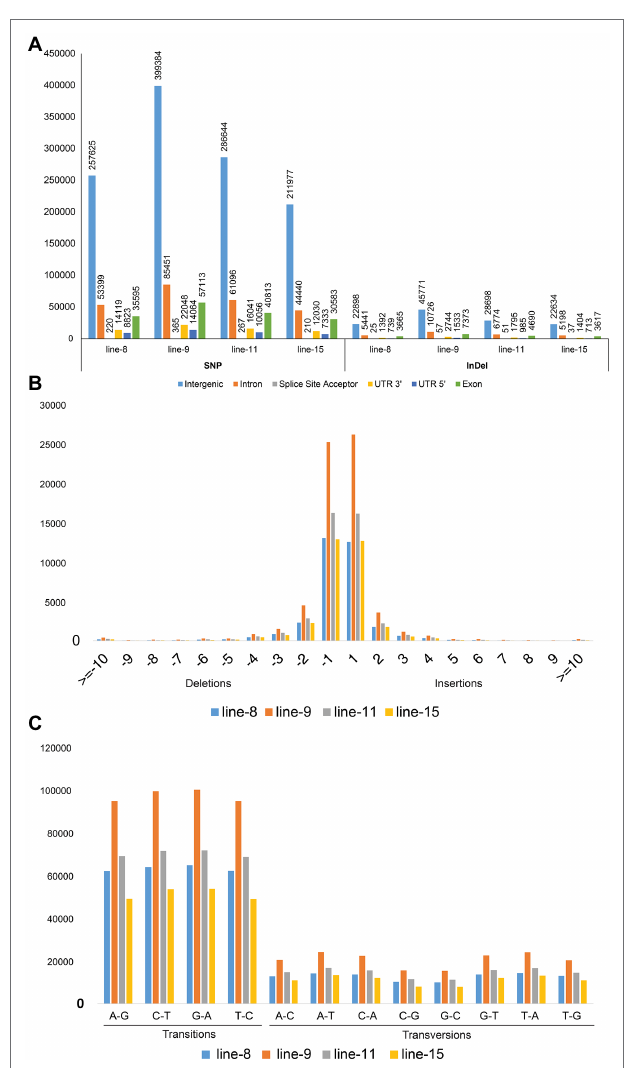
FIGURE 4 | Annotation of SNP and InDel variants identified in mutant lines 8, 9, 11, and 15; (A) Annotations of SNP and InDel variants by their location; (B) Size distribution of identified InDels; and (C) Type of SNP variants by base substitution in mutant lines.